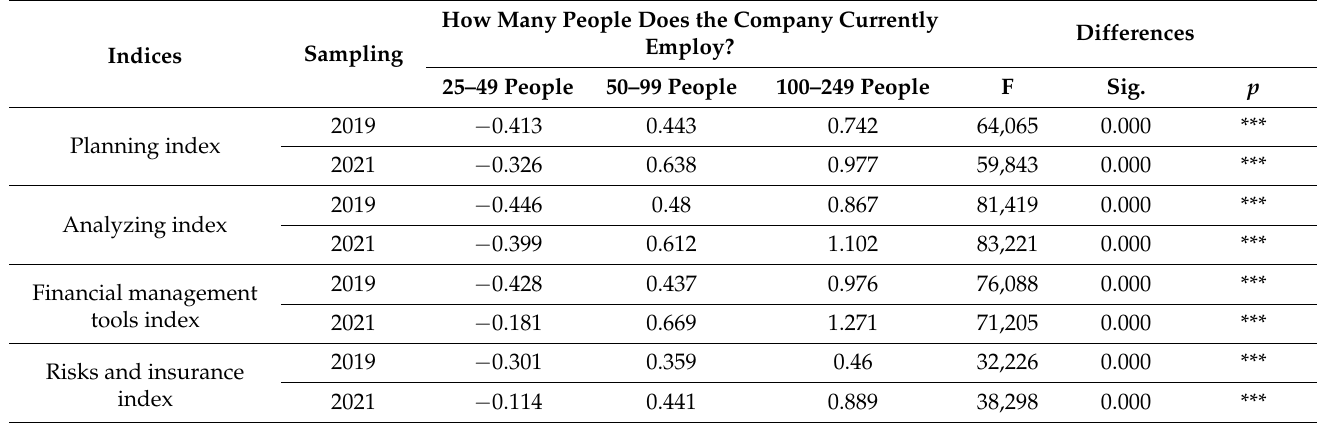
Table 5. Development of averages of normalized indices by company